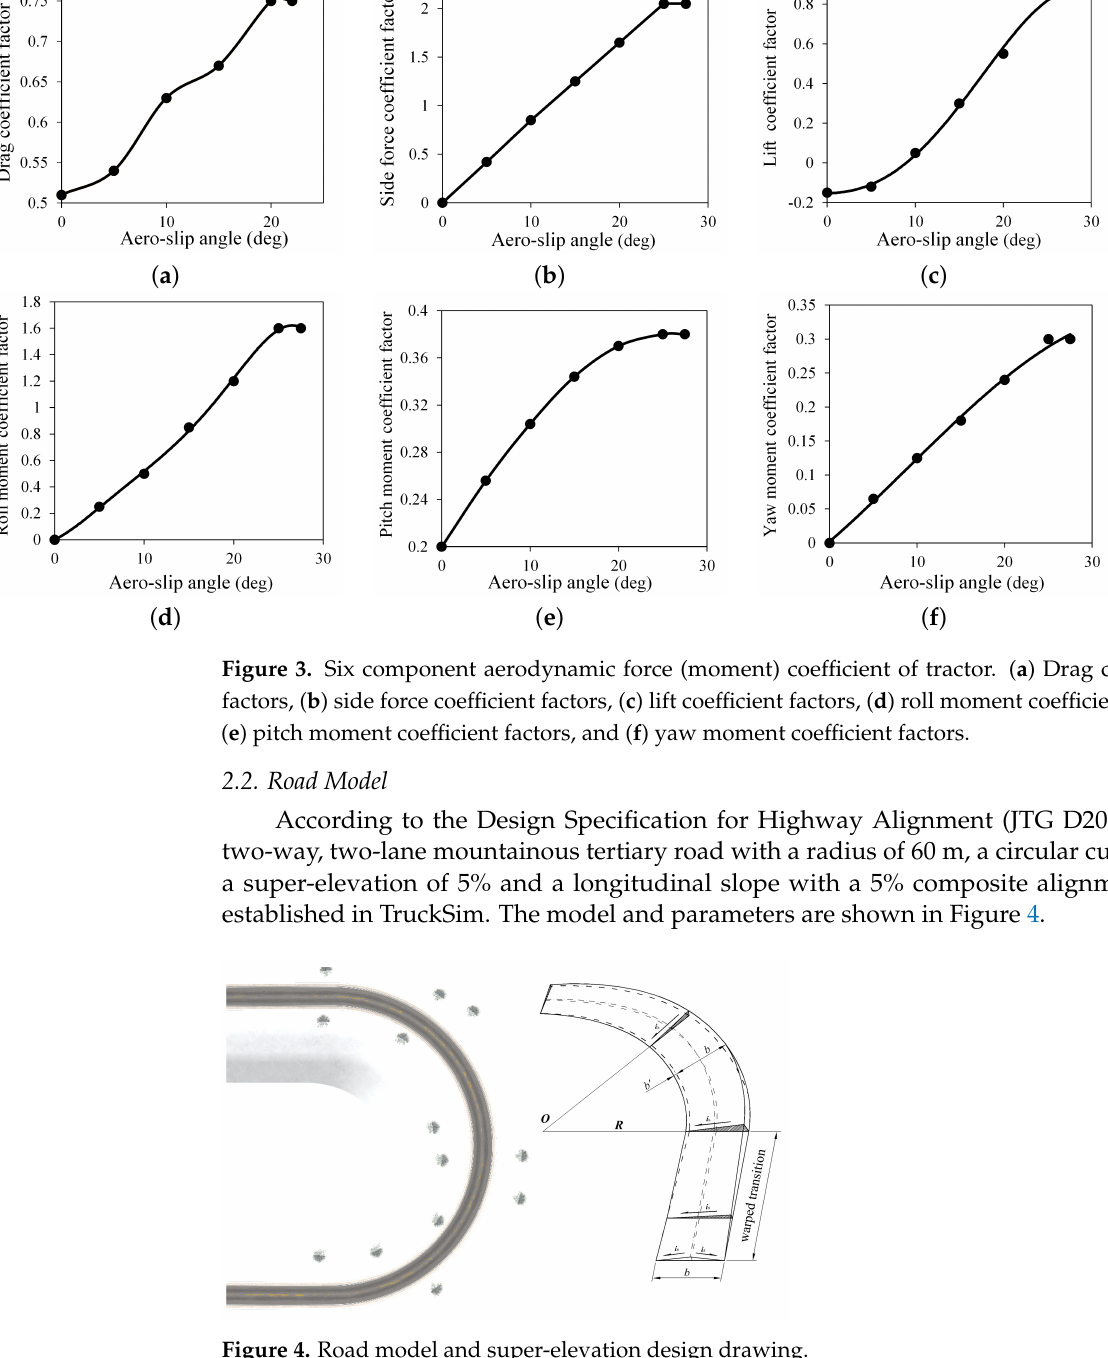
Figure 4. Road model and super-elevation design